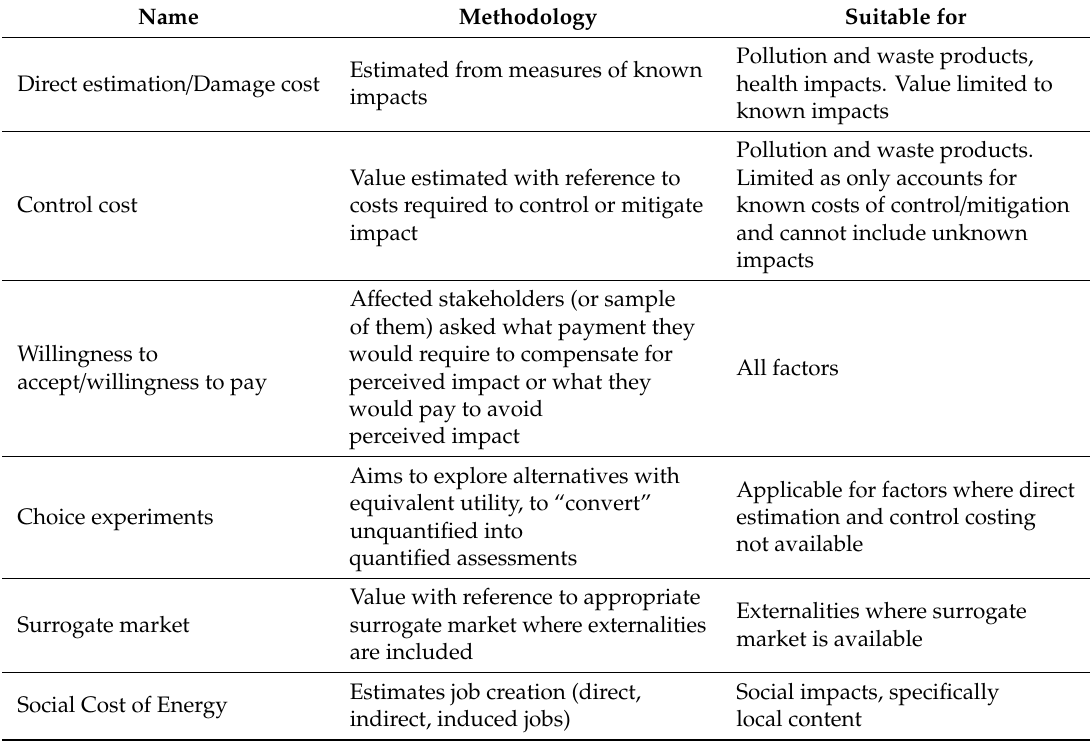
Table 3. Evaluation methods for externalities (authors’